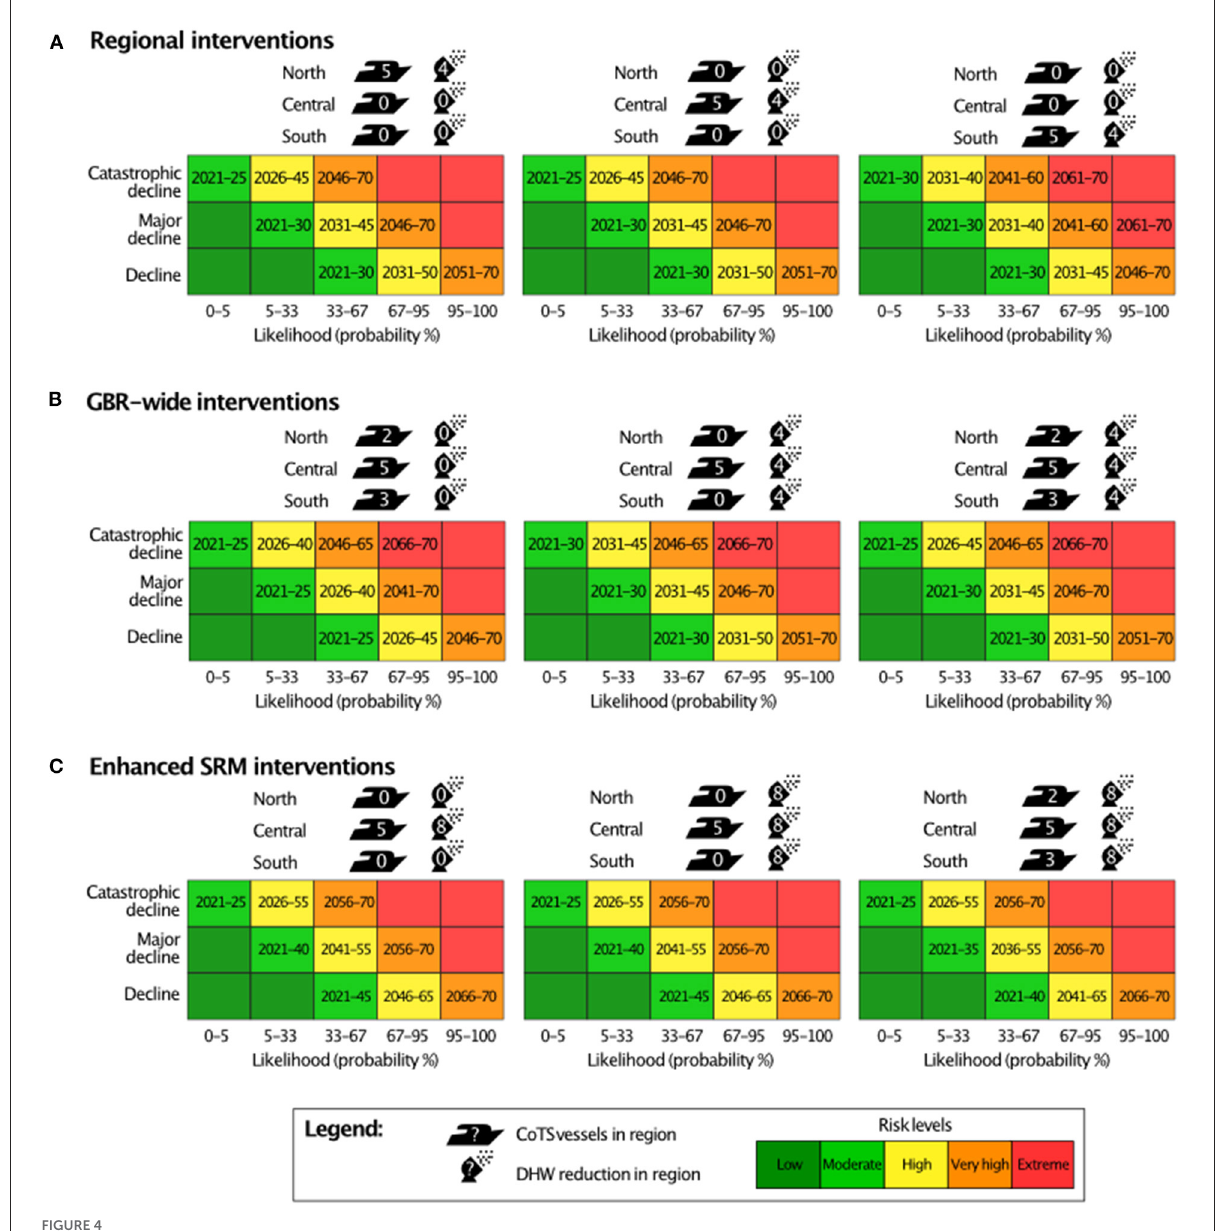
FIGURE4 Comparisons of risk to coral cover (percentage of available reef habitat averaged over all reefs on the GBR and 5-year blocks over the period 2021–2070) under a range of global climate action and regional intervention scenarios, each based on 100-run ensembles. In each case, the vessel icon indicates the number of CoTS control vessels operating and the cloud generator icon indicates the reduction in DHW within each region. (A) Risk matrices for interventions focusing exclusively in the northern, central, or southern parts of the GBR (scenarios 4–6). (B) Risk matrices for interventions with zero or modest levels of SRM (4 DHW) distributed across the entire GBR and two levels of CoTS control (scenarios 7–9). (C) Risk matrices for interventions with enhanced levels of SRM (8 DHW) and two levels of CoTS control (scenarios 10–12). The selected risk level descriptors (and colors) are only illustrative and can be modified to align with the objectives of any risk